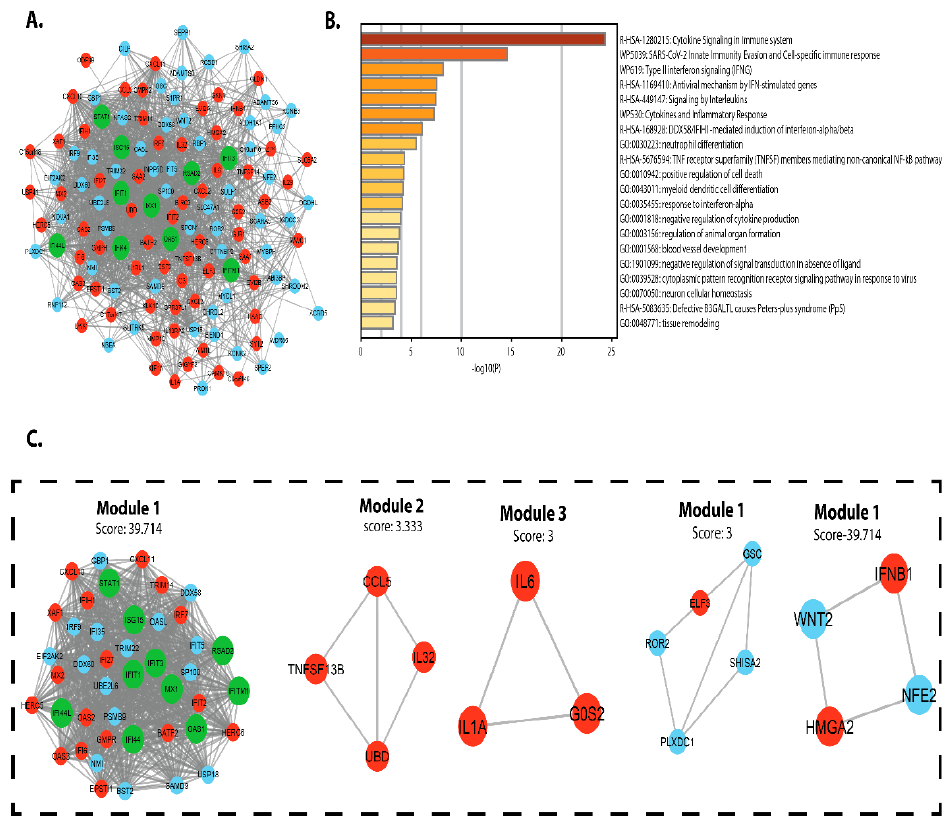
Figure 5. PPI network construction of differential expressed genes in C. parvum infected patient’s intestinal epithelial tissue ( A ) PPI network of CPI DEGs red circles represents upregulated DEGs, cyan circle represents downregulated DEGs, and the green circle represents hub genes. ( B ) p -values are used to colour a bar graph of enriched terms across all total expressed genes. ( C ) The most significant module was obtained from PPI